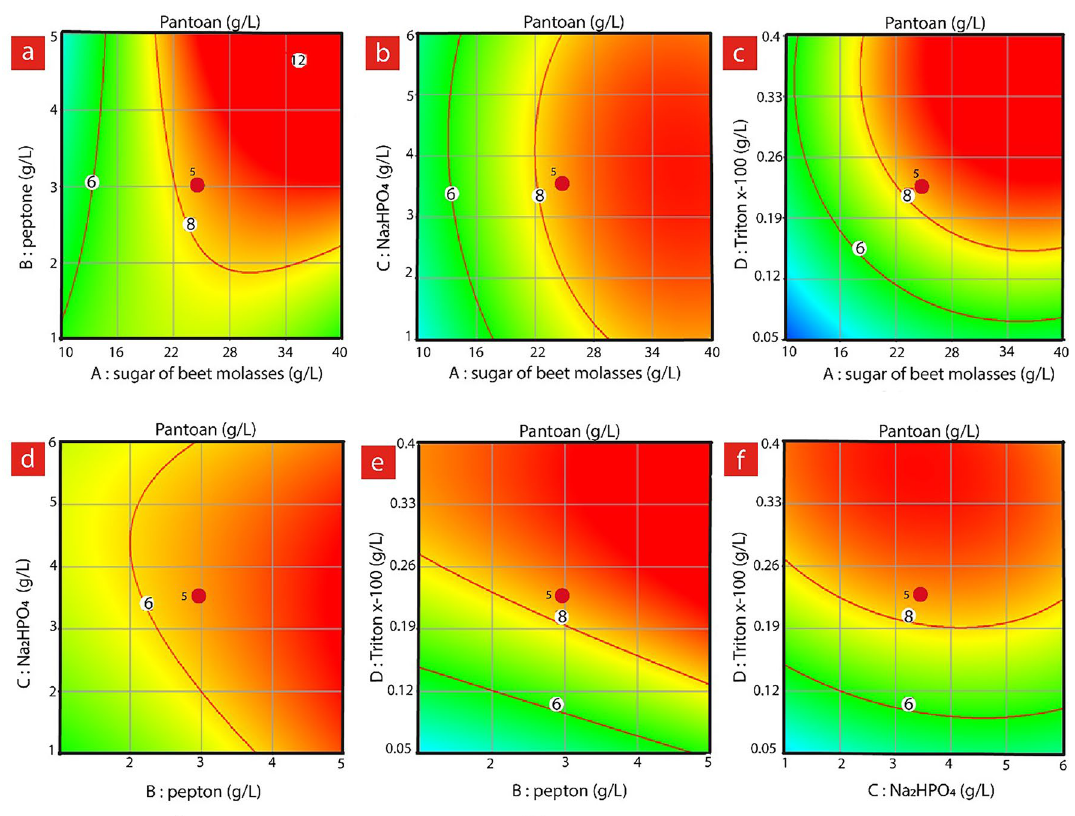
Figure 3. Effect of different concentrations of SBM, peptone, Na 2 HPO 4 , and Triton X-100 on Pantoan production using Design Expert software (Version 10.0.7.0, Stat-Ease Inc., Minneapolis, USA). The rate of production is shown based on the lowest (green color), medium (yellow), and highest (red color). ( a ) concentrations (g/L) of the peptone and SBM at constant concentration of Na 2 HPO 4 , and Triton X-100, ( b ) concentrations of the Na 2 HPO 4 and SBM at constant concentrations of peptone and Triton X-100, ( c ) concentrations (g/L) of the Triton X-100 and the molasses at constant concentrations of peptone and Na 2 HPO 4 , ( d ) concentrations (g/L) of the peptone and the Na 2 HPO 4 at constant concentrations of Triton X-100 and molasses, ( e ) concentrations (g/L) of the peptone and the Triton X-100 at constant concentrations of Na 2 HPO 4 and SBM, and ( f ) concentrations (g/L) of the Na 2 HPO 4 and the Triton X-100 at constant concentrations of peptone and